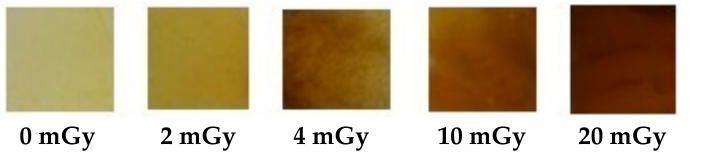
Figure 2. Visual color change of PVA/NBT films before and after exposure to varying doses of X- radiations.